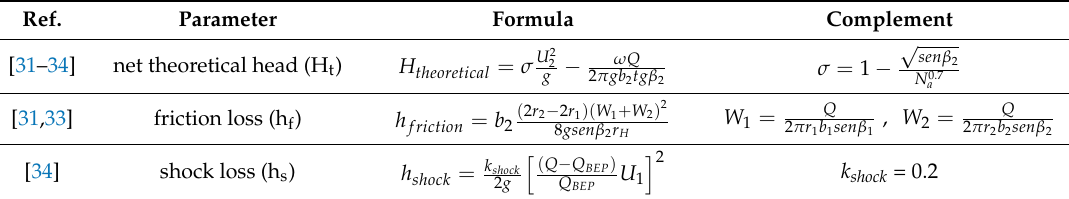
Table 2. Formulations to estimate the head of PAT [26].